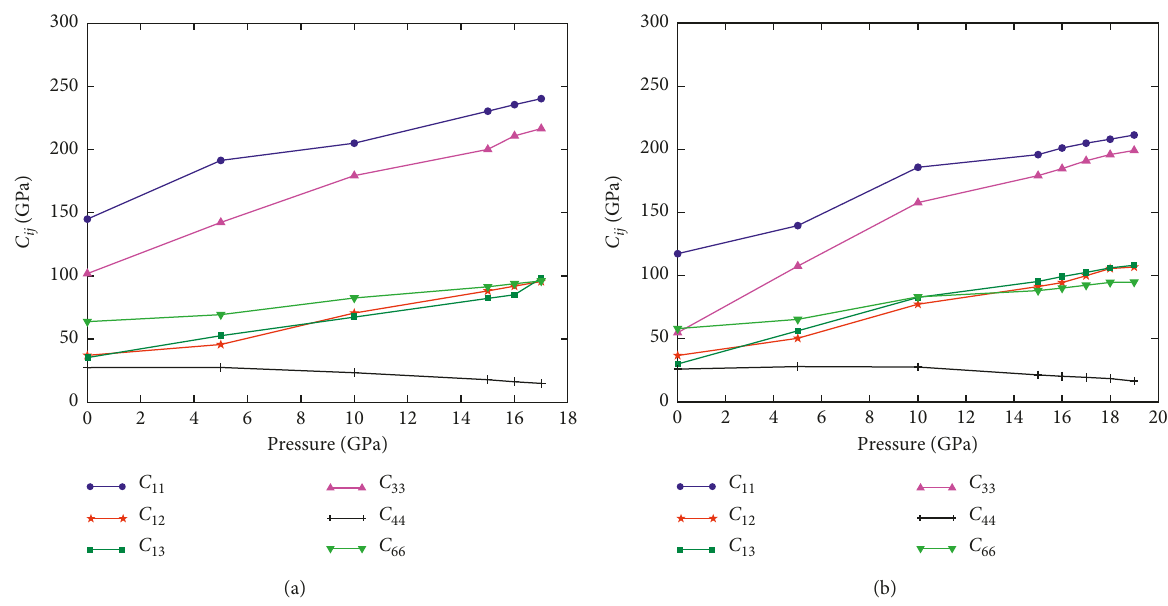
Figure 2: The pressure dependence of the elastic constants for (a) LiFeAs and (b) NaFeAs, respectively.